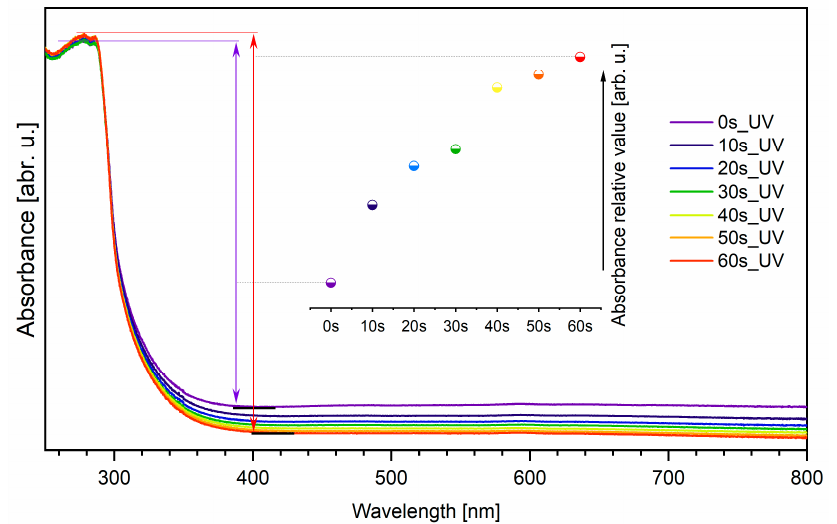
Figure 6. Fourier-transformed mid-infrared spectra of neat EverStick post, UV light-cured EverStick post, Mirafit White and GC Fibre post ( top ) and the structural formula of bisphenol A–glycidyl methacrylate (bis–GMA) ( bottom left ) and poly (methyl methacrylate) PMMA ( bottom right ).